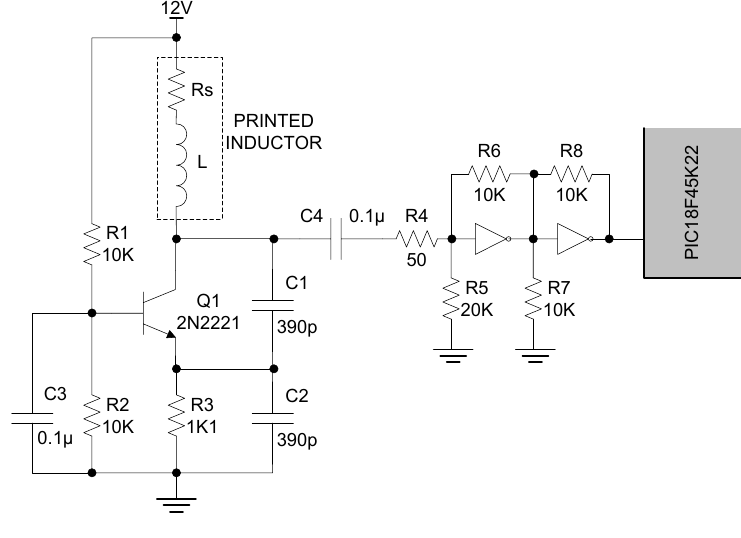
Figure 7. Complete electrical scheme of fabricated inductor as a part of oscillator circuit.